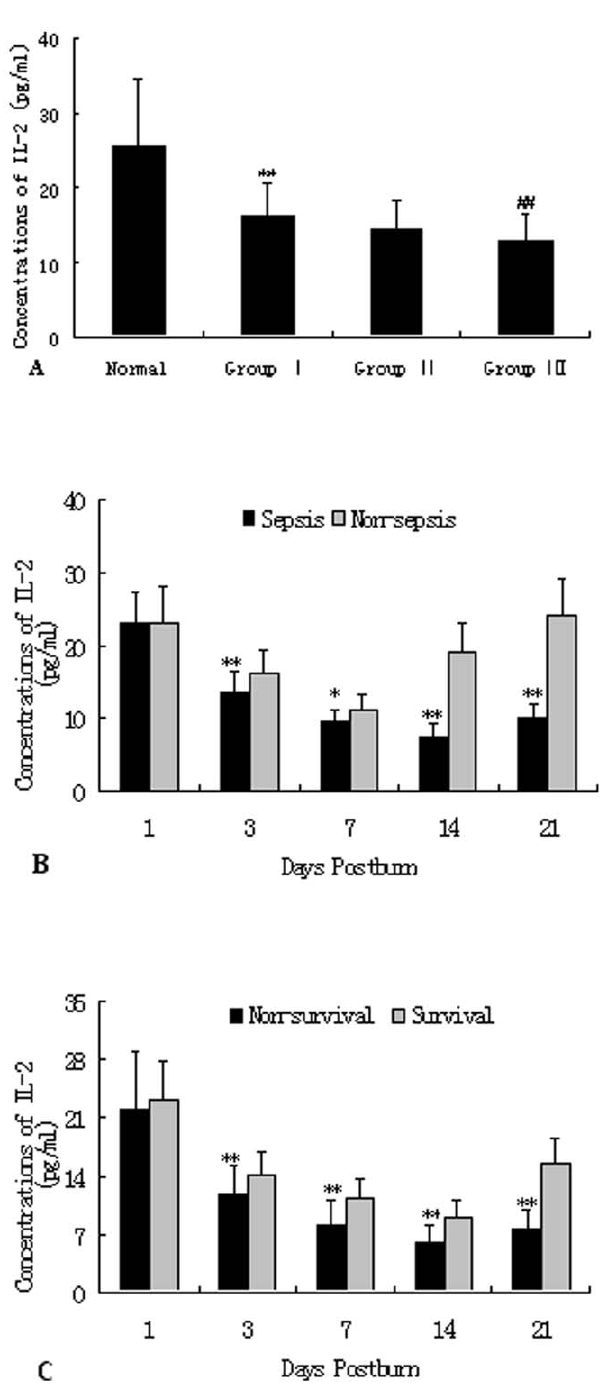
Figure 4. ELISA analysis of IL-2 levels released by T cells. Decreased expression of IL-2 released by T cells from burned patients was noted on PBD 1–21 in comparison to normal controls, and there were obvious differences among patients in Group I and Group III (Fig. 3A). Protein levels of IL-2 of T cells were significantly lower in patients with MODS than those without MODS on PBD 3–21 (Fig. 3B). Among patients with MODS, IL-2 levels in the survivors were obviously higher than those with non-survivors on PBD 3–21 (Fig. 3C). *P , 0.05, **P , 0.01, Group I vs. normal group, or MODS group vs. non-MODS group, or non-survivors group vs. survivors group; ## P , 0.01, Group III vs. Group I.